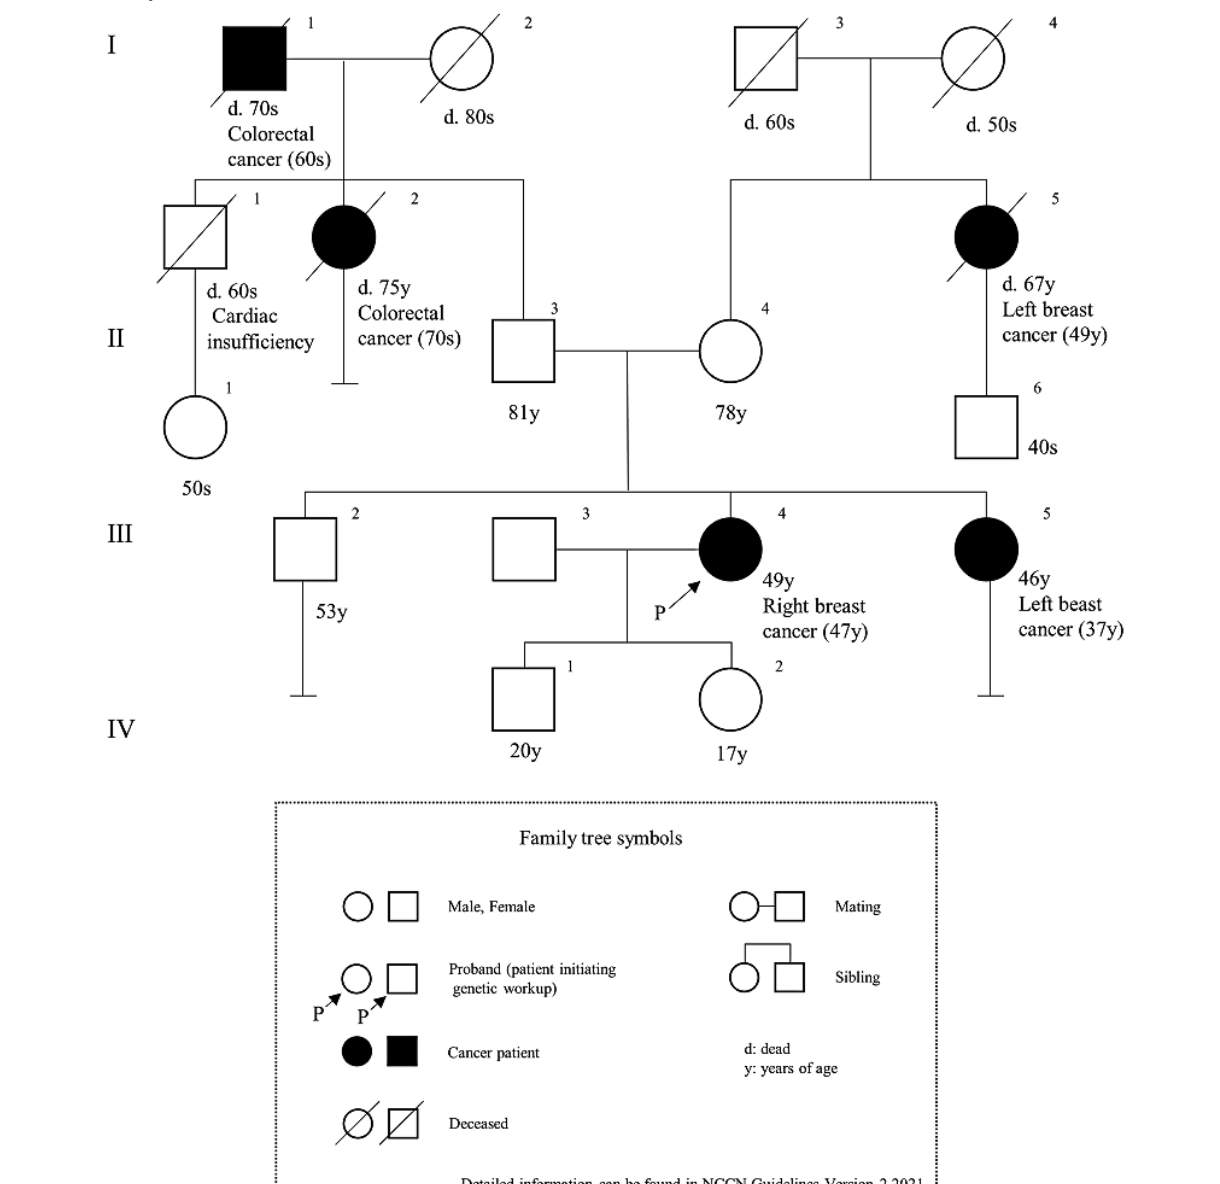
Figure 1. The family tree in scenario